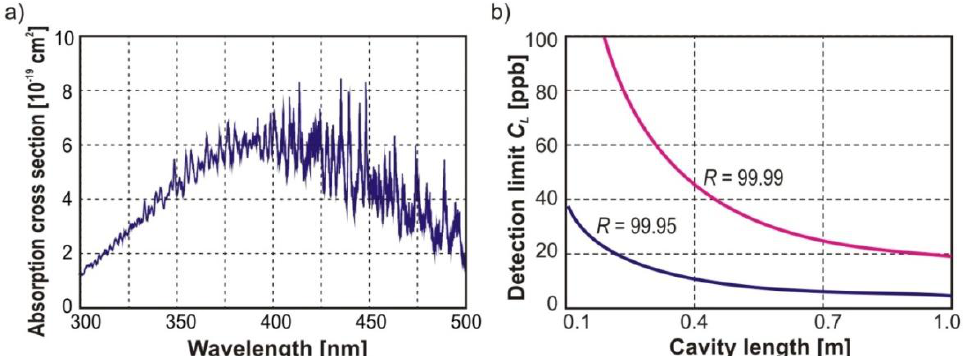
Figure 3. NO absorption spectrum ( a ) and dependence of the detection limit on the cavity 2 length and the reflectivity of mirrors R ( b ).